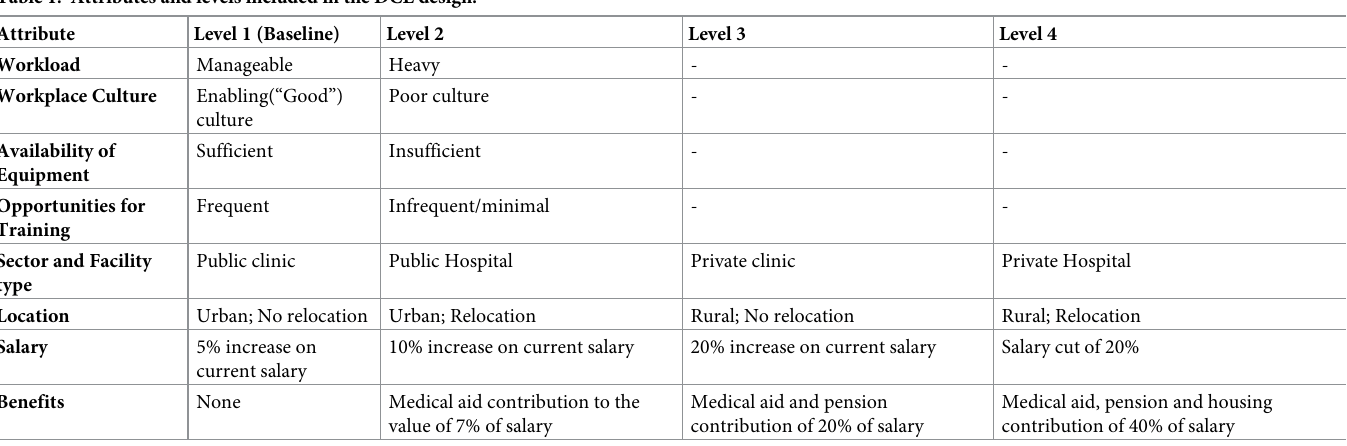
Table 1. Attributes and levels included in the DCE